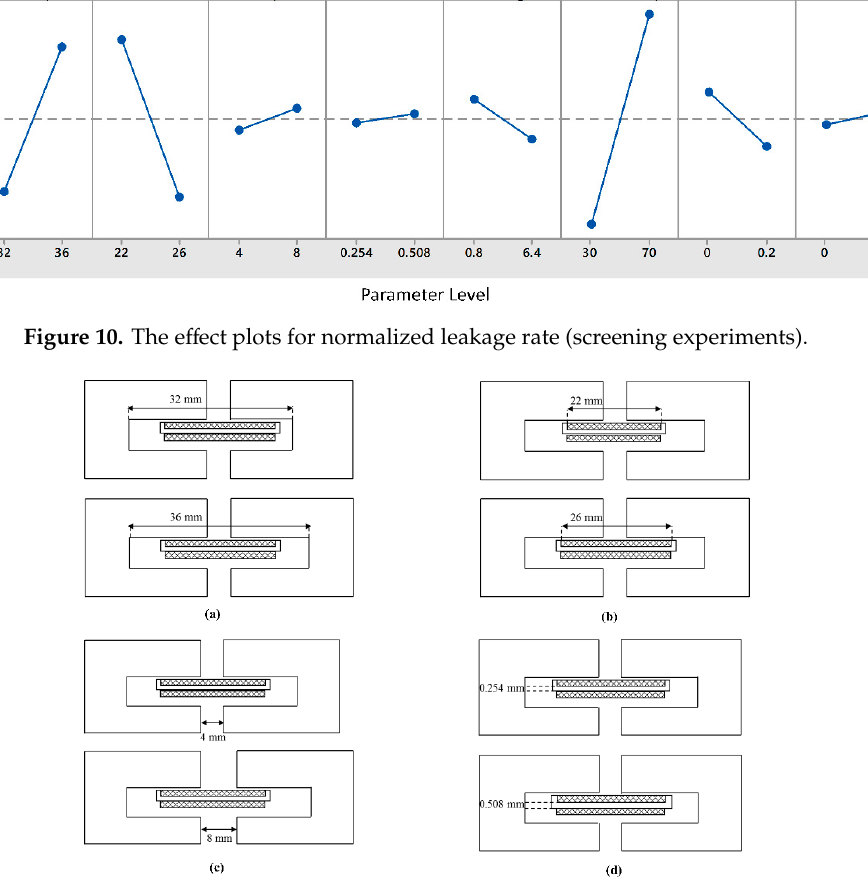
Figure 11. Diagrams for dimensional changes, ( a ) slot depth; ( b ) cloth width; ( c ) gap; ( d ) shim thickness.